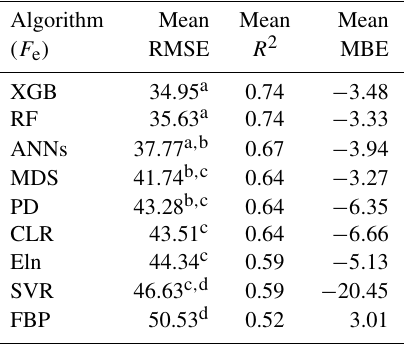
Table 7. The average metrics for F e gap-filling based on the algo- rithms, ranked by RMSE using the Tukey’s HSD test at the level of 0.05.